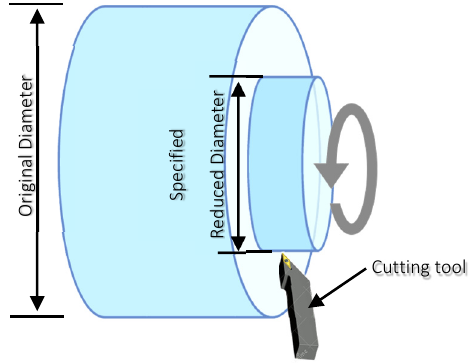
Figure 4. Rod diameter reduction via turning manufacturing process.